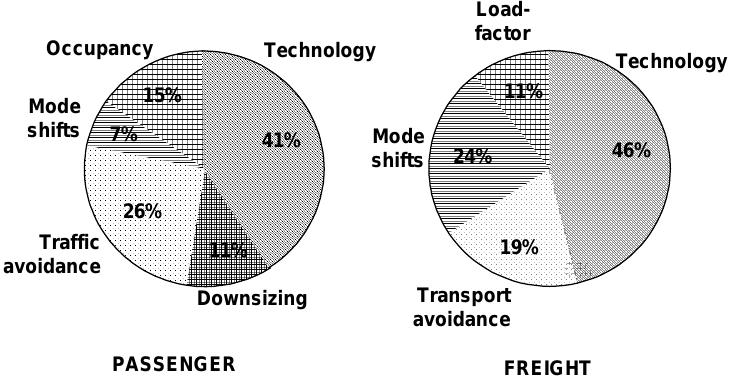
Figure 5. Contribution of technology and mobility management measures to EST in